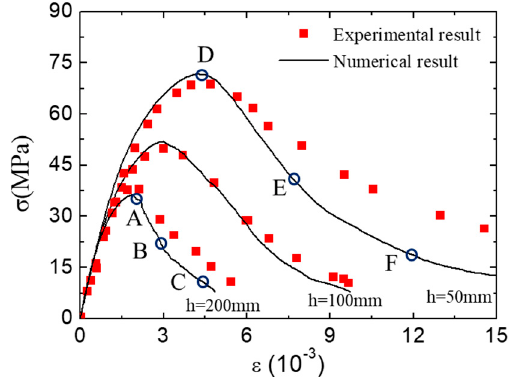
Figure 21. Stress–strain curve of concrete specimens with different heights.